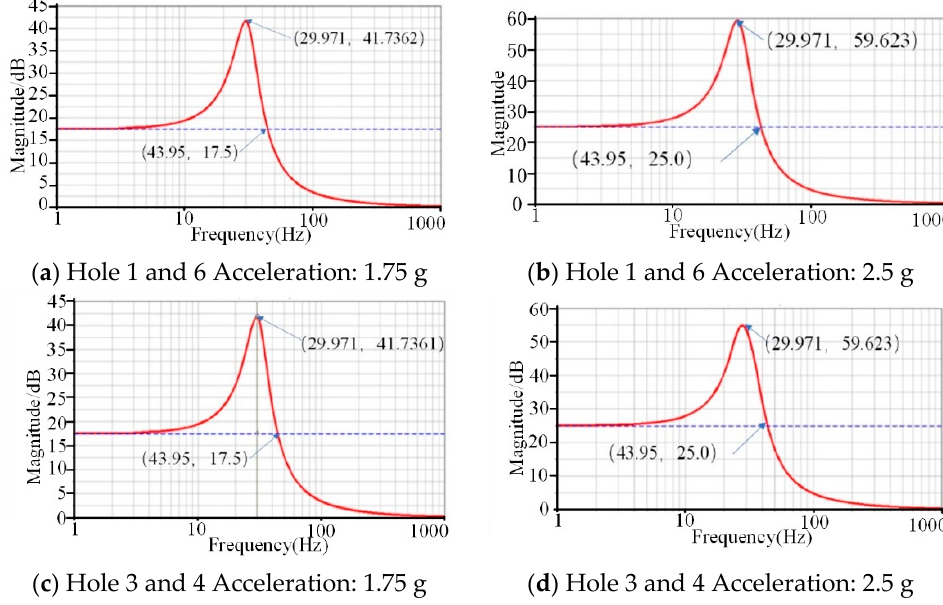
Figure 8. The frequency response curve of the symmetrical distribution of vibration isolators. Table 2. Frequency-response results.